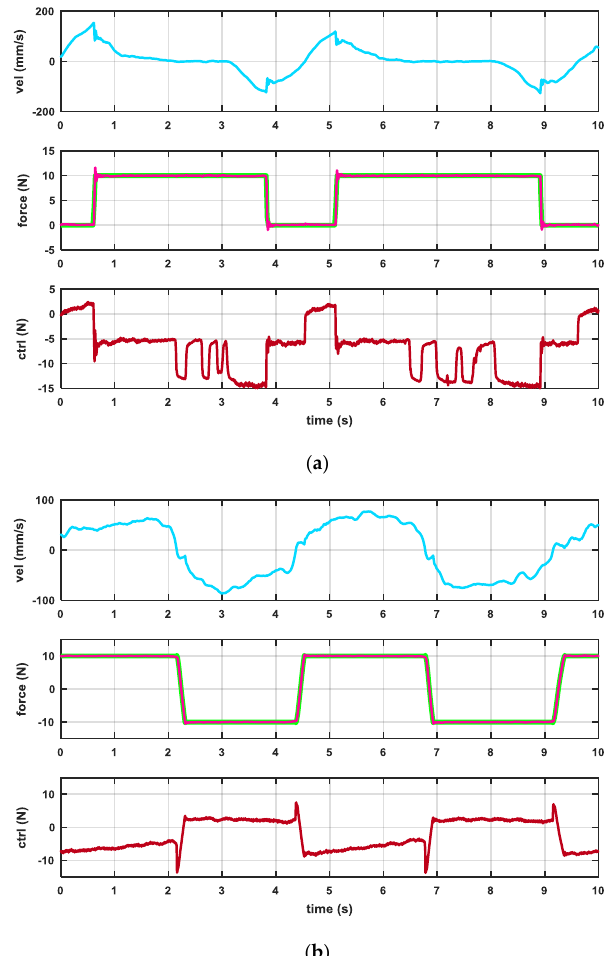
Figure 16. The control response with the optimal control gains ( D = 1000 rad / s, m d m = 0.5 kg): ( a ) Constant return force; ( b ) friction force.